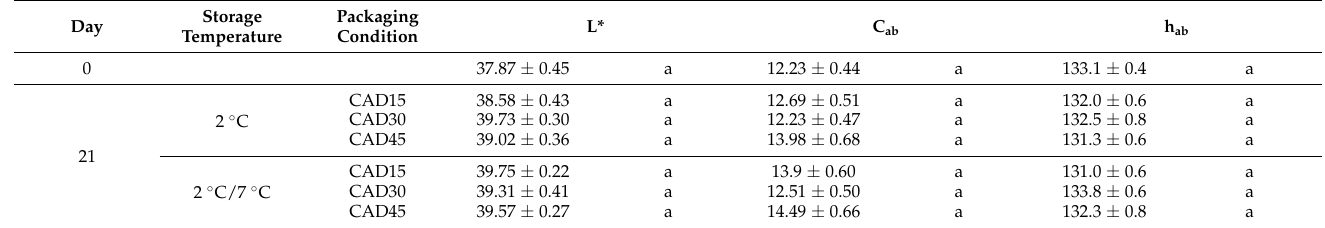
Table 2. Colorimetric parameters (L*, C ab and h ab ) of broccoli florets packaged in films with different levels of micro-perforation (CAD15, CAD30 and CAD45) and storage for 21 days at 2 ◦ C and 2 ◦ C/7 ◦ C, and comparison with florets freshly harvest (day 0). Data are expressed as means ± standard